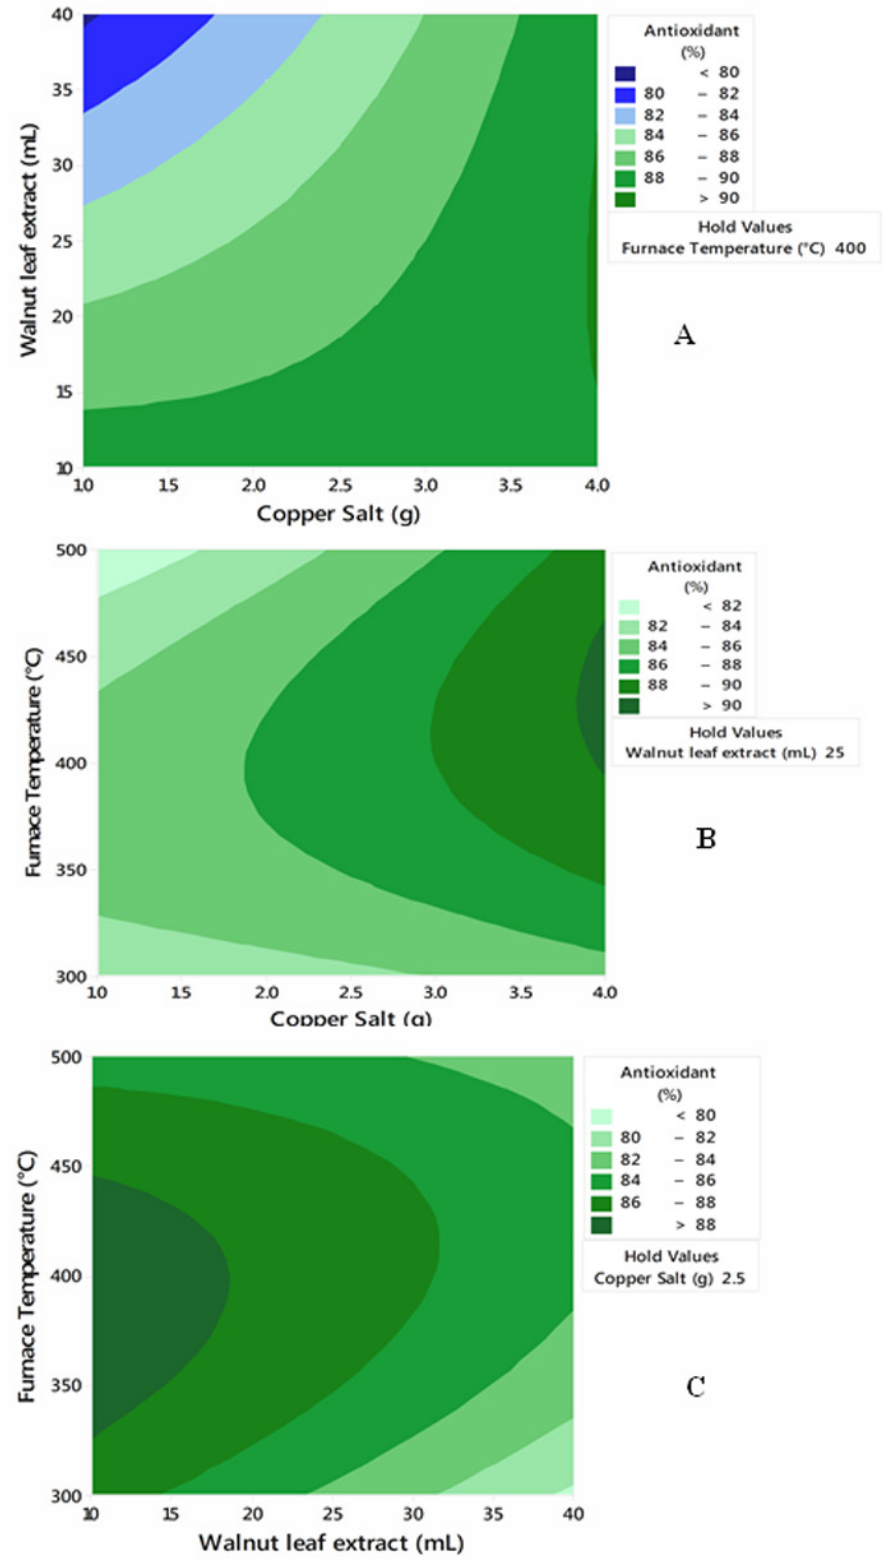
Figure 2: Contour plots for antioxidant activity of the formed CuO NPs as function of copper salt and walnut leaf extract amounts (a), copper salt amount and furnace temperature (b), and amount of copper salt and furnace temperature